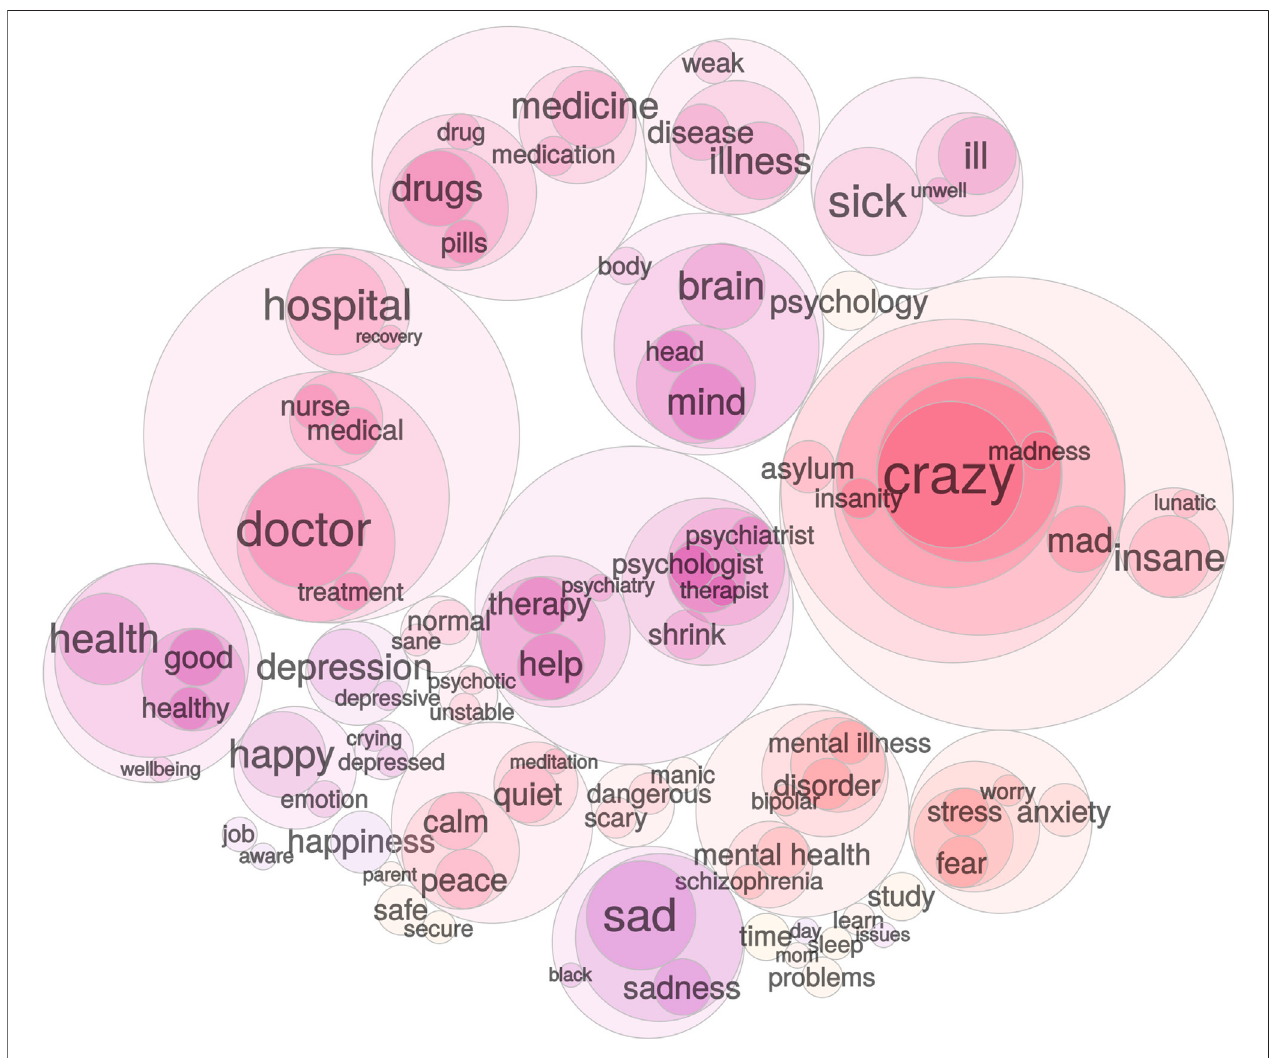
FIGURE 2 | Word association egograph for the word “ mental health ” . Colors indicate distinct clusters of meaning extracted using walktrap clustering. Cluster size indicates the prevalence of association responses measured as response in-strength (i.e., the sum of weighted incoming edges).